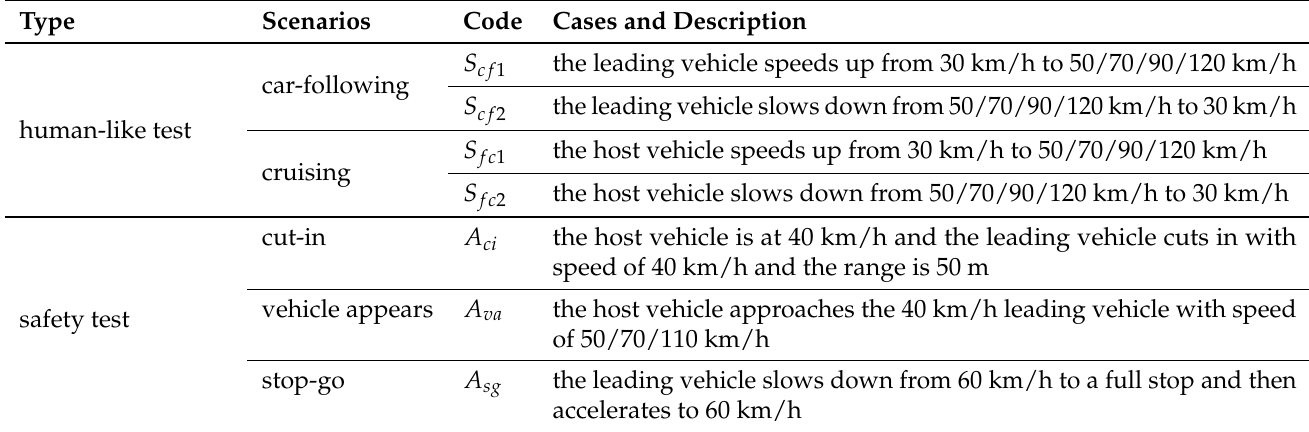
Table 1. List of testing